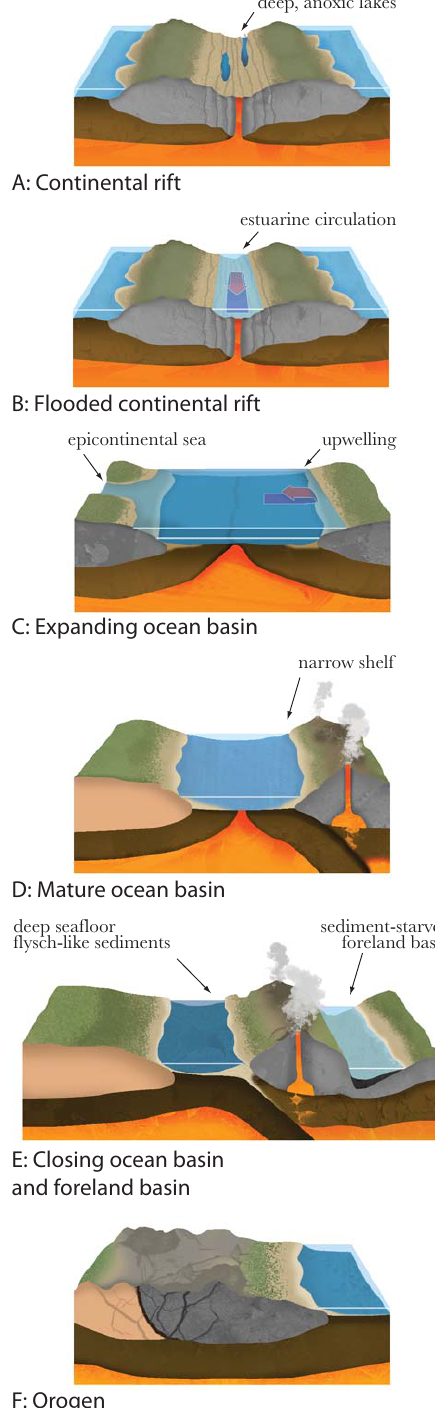
Fig. 3. Schematic overview of the Wilson Cycle. The different blocks show a schematic overview of the development and closure of an ocean basin. Annotations refer to environments where black shales may accumulate and to processes that intervene in the forma- tion of black